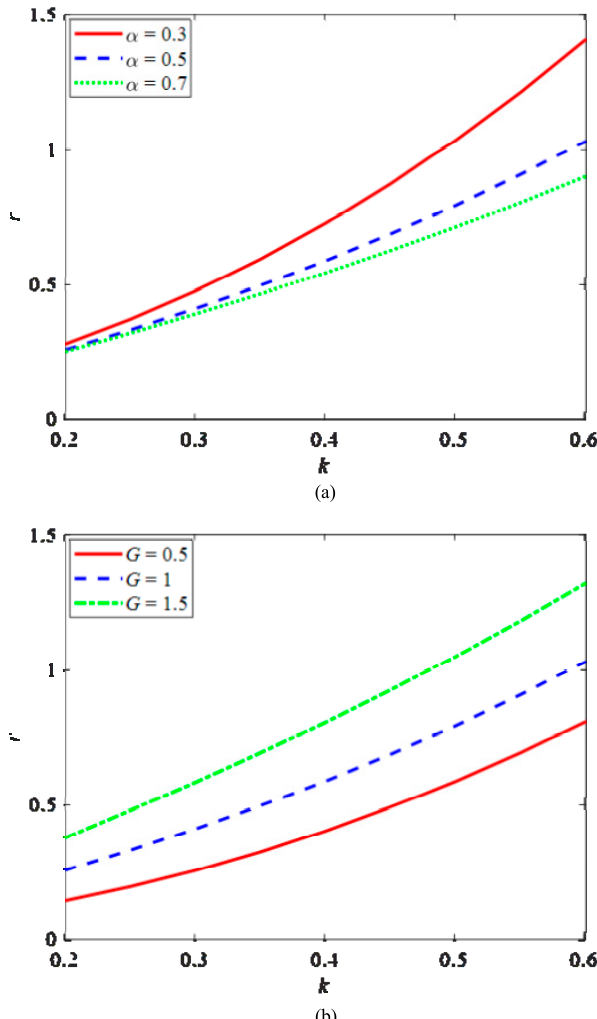
Figure 3. The ratio of I L f and I 1 varying with k ( a ) Under different α ( b ) Under different G .